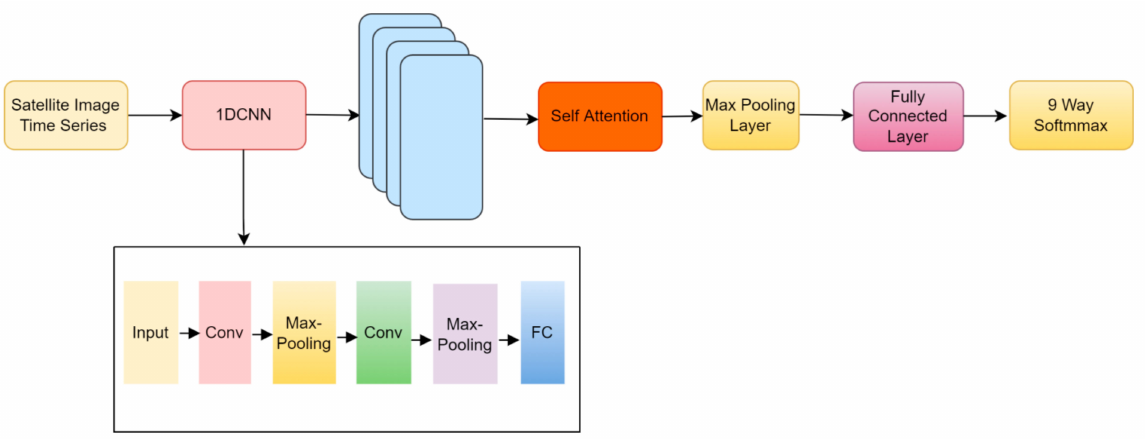
Figure 4. Attention on temporal